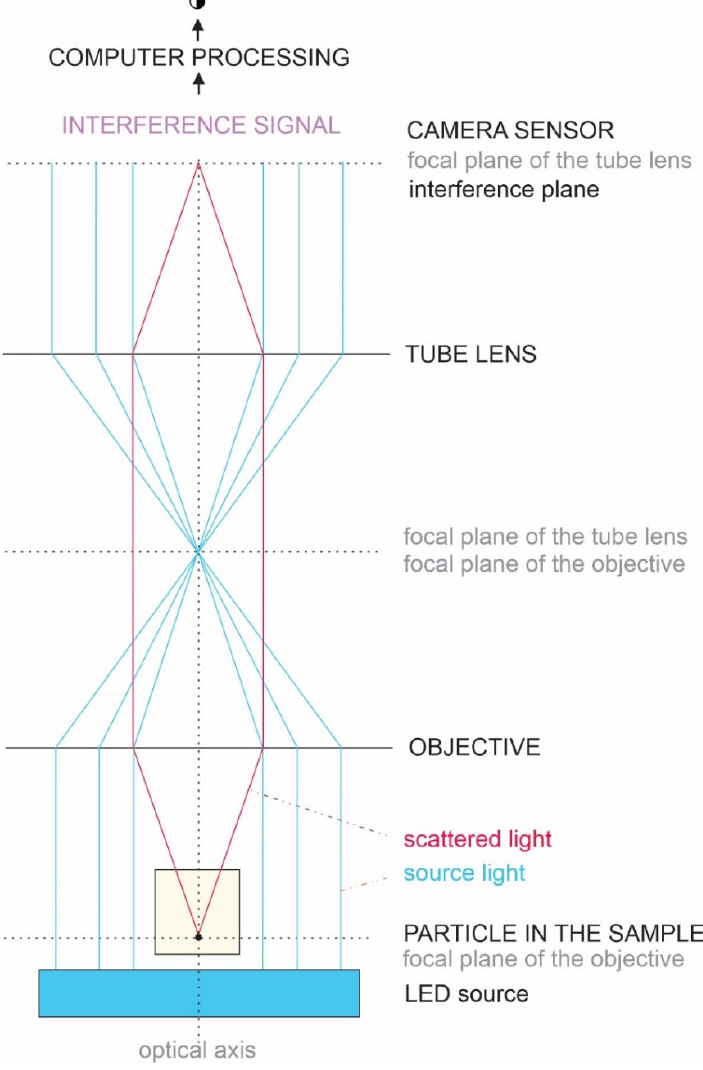
Table 4. Experimental error in selected samples from B,S,P, and L sources.